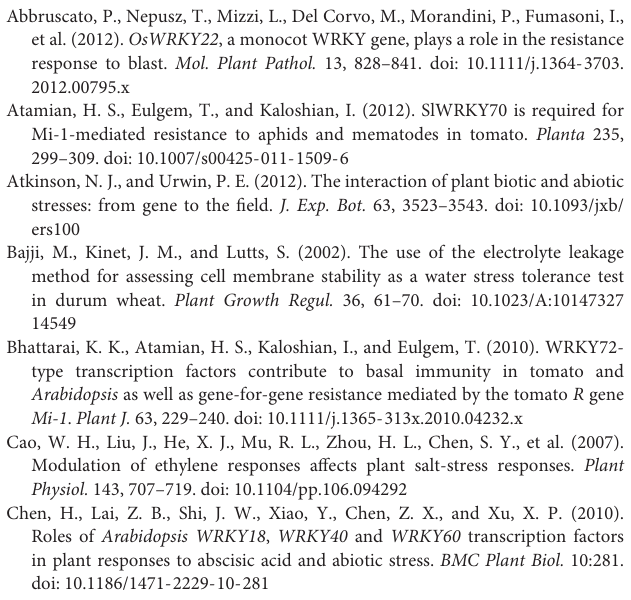
FIGURE S3 | ROS levels in WT and VlWRKY3 transgenic Arabidopsis thaliana plants post Botrytis cinerea infection 48 h. (A,B) Histochemical staining assay of H 2 O 2 and O 2 − accumulation with nitro blue tetrazolium (NBT) (A) and diaminobenzidine (DAB) (B) in WT and transgenic leaves. The experiment was repeated 3 times with 5–10